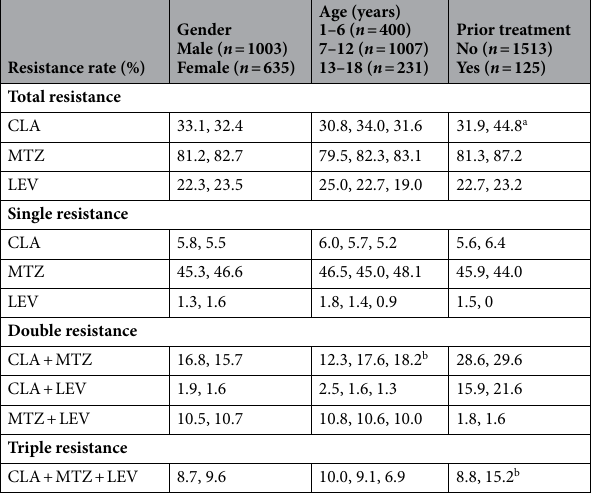
Resistance rate